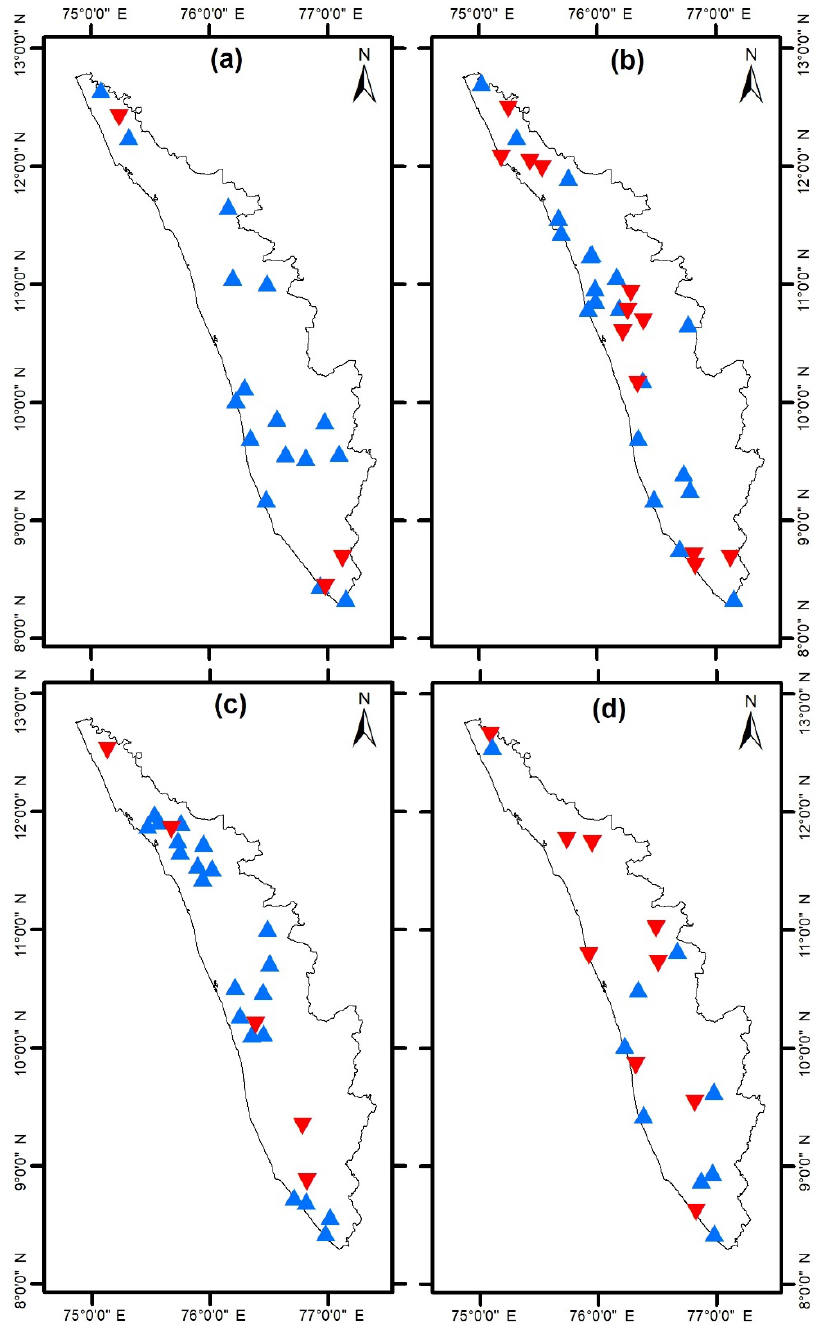
Figure 12. The positive (blue) and negative (red) normalized difference vegetation index trend of locations 19-32-26-18 during ( a ) January, ( b ) April, ( c ) August, and ( d ) November.